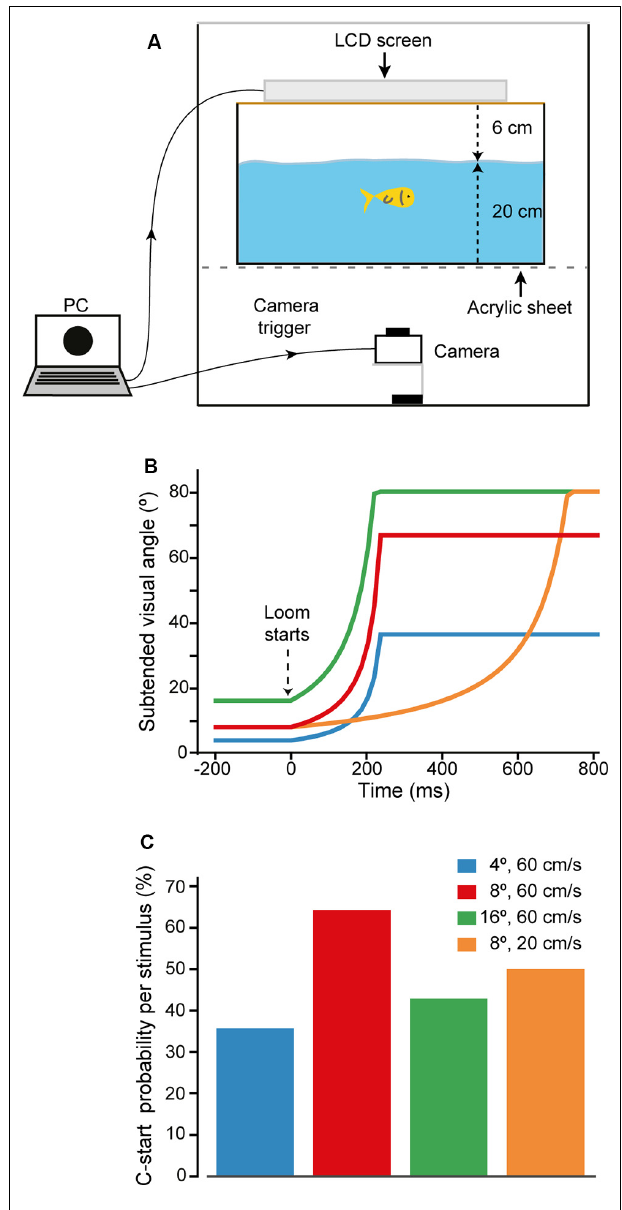
FIGURE 1 | Looming evoked escapes in goldfish. (A) Behavioral setup. Computer-generated visual looms were delivered through an LCD screen located on top of the experimental aquarium, which stands on a transparent acrylic platform. Fish behavior and looming expansion were filmed from below at 240 or 480 fps. The same computer triggered acquisition of the camera. (B) Time course of the stimuli used to characterize response probability to high contrast visual looms. Stimuli differed in their initial subtended angle (4 ◦ , 8 ◦ , or 16 ◦ ) or expansion velocity (20 or 60 cm/s). (C) C-start probability for each of the looms used. After this initial characterization, the stimulus that evoked maximal C-start probability, loom onset at 8 ◦ and expanding at 60 cm/s (red), was chosen for the rest of the